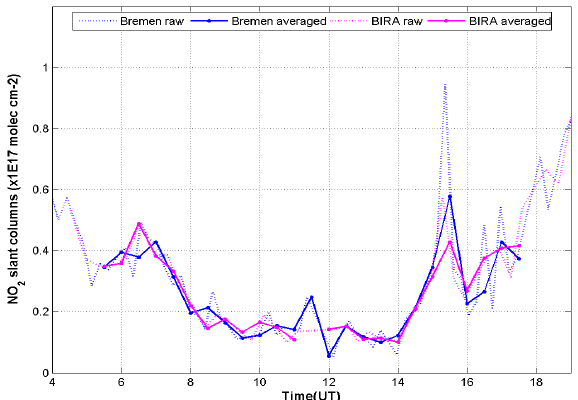
Fig. 4. Comparison of raw and 30-minute averaged slant columns of NO 2 measured by Bremen and BIRA, on 19 June 2009 at elevation 15°. These are weighted averages, using as a weight the inverse square of the error of each data point given by its spectral fit. Measurements by BIRA are missing near local noon because BIRA investigators chose a longer period of measurements at 90° elevation in order to increase the chances of a cloud-free reference spectrum for the day.